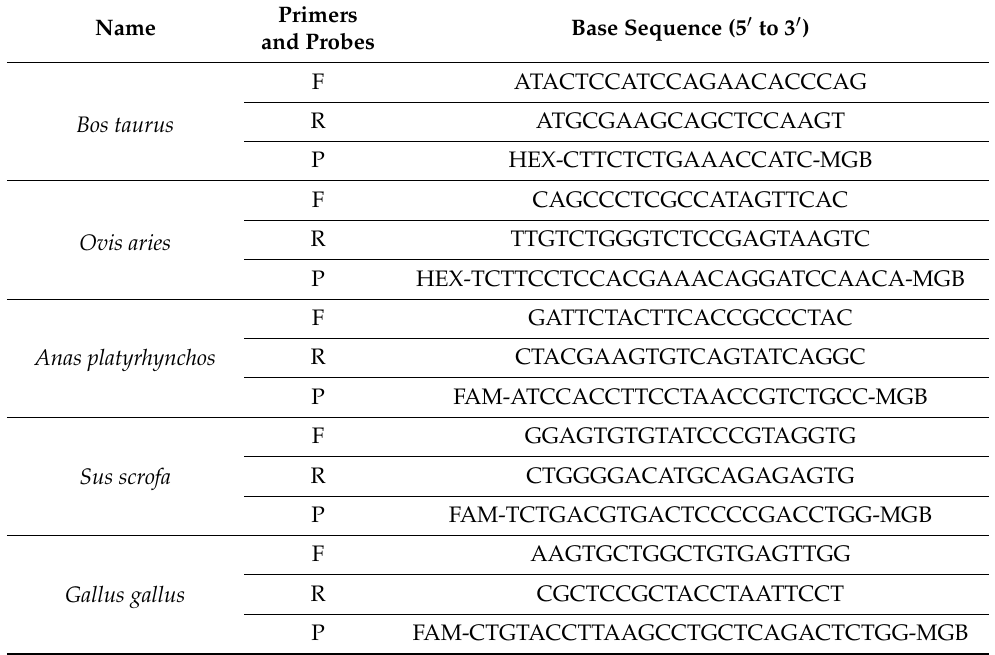
Table 1. Primer and probe